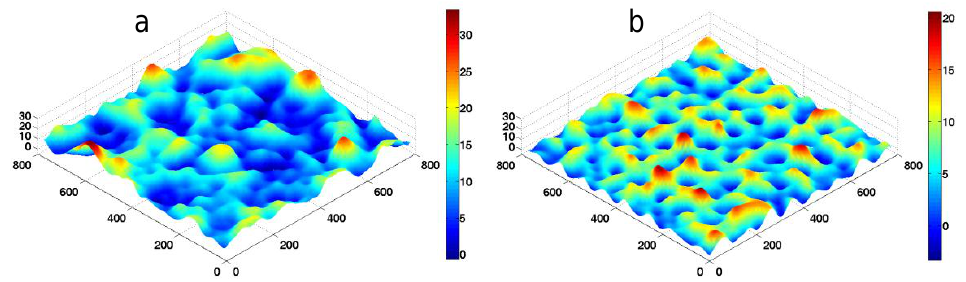
Figure 3. Snapshots of fluctuating membranes in the FSBD-MC simulations. ( a ) k = 1 pN/nm; ( b ) k = 100 pN/nm.